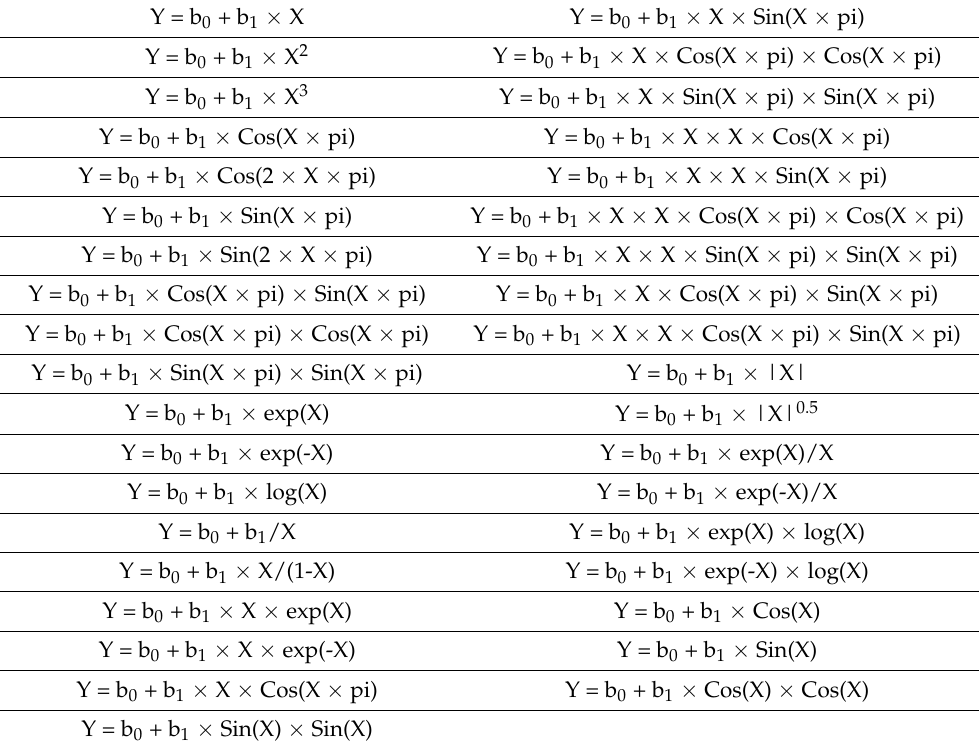
Table A1. List of 37 functions for the explanatory variable in nonlinear regression.